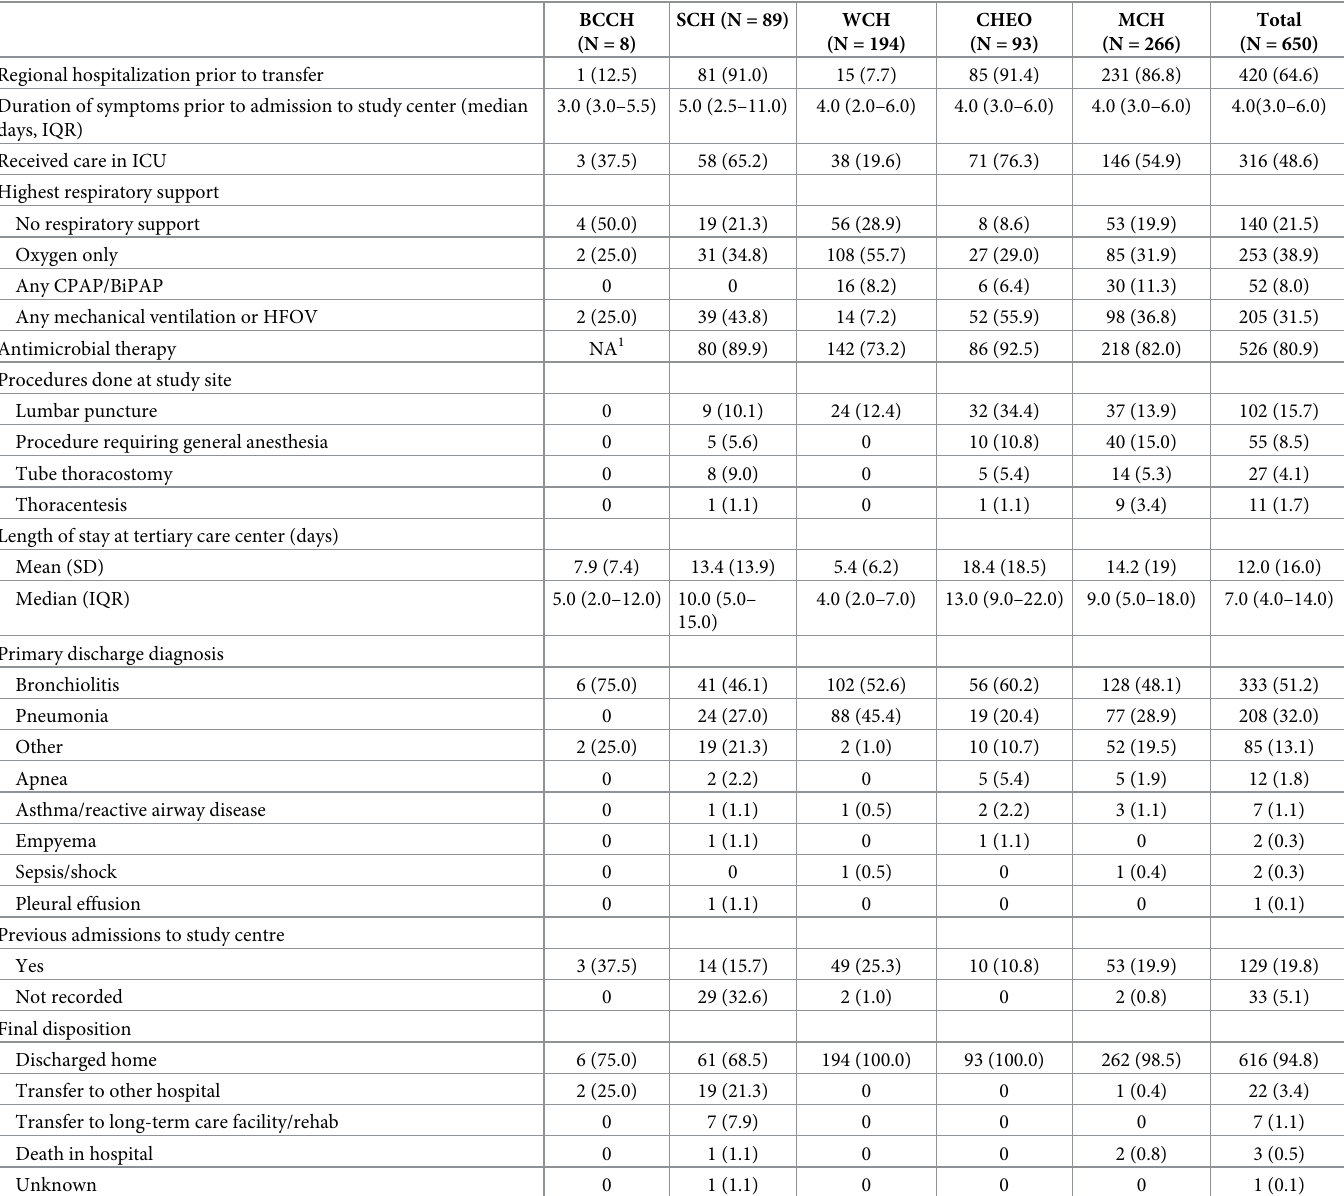
Table 3. Clinical characteristics of 650 children transported urgently by air from northern Canada to five tertiary care centers (n,